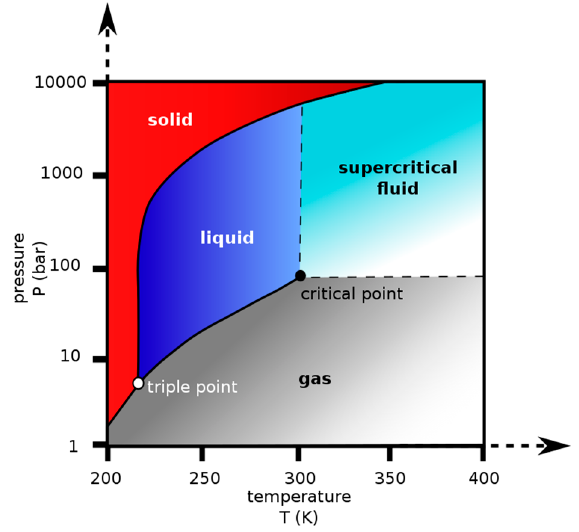
Figure 3. Phase diagram of CO 2 .